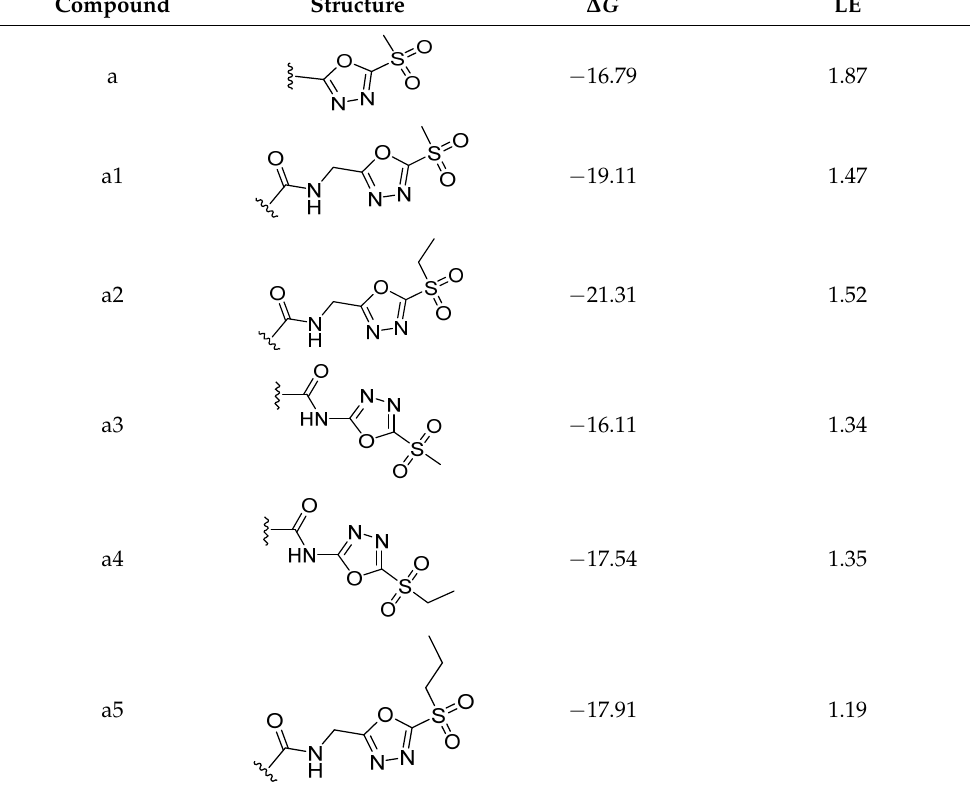
Table 2. The optimization analysis of compound a .